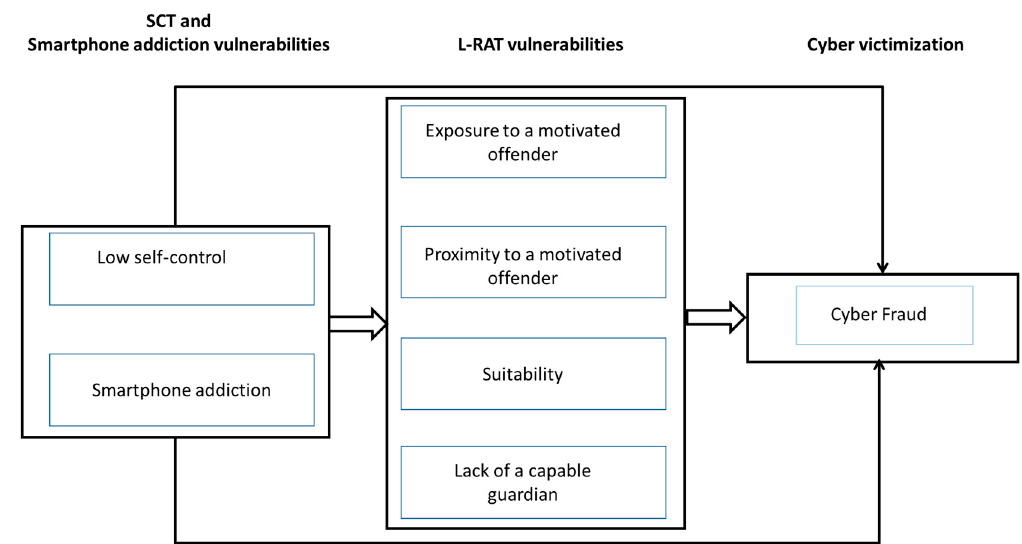
Figure 1. Vulnerabilities stemming from self-control theory (SCT), smartphone addiction and lifestyle-routine activities (L-RAT) and cyber fraud: the user’s dual vulnerability model of cybercrime victimization.